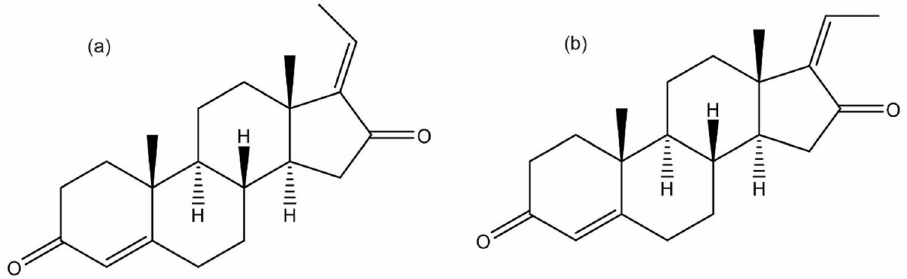
Figure 1. Chemical structure of E – guggulsterone (a) and Z – guggulsterone